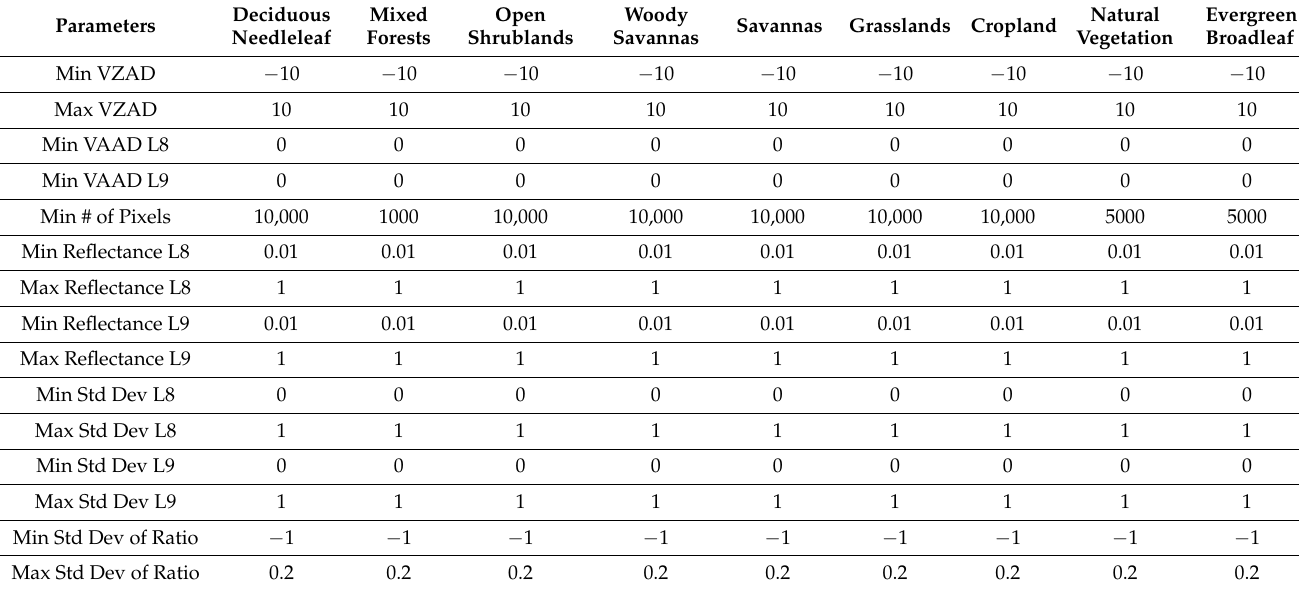
Table A1. Vegetation-filtering algorithm parameters.